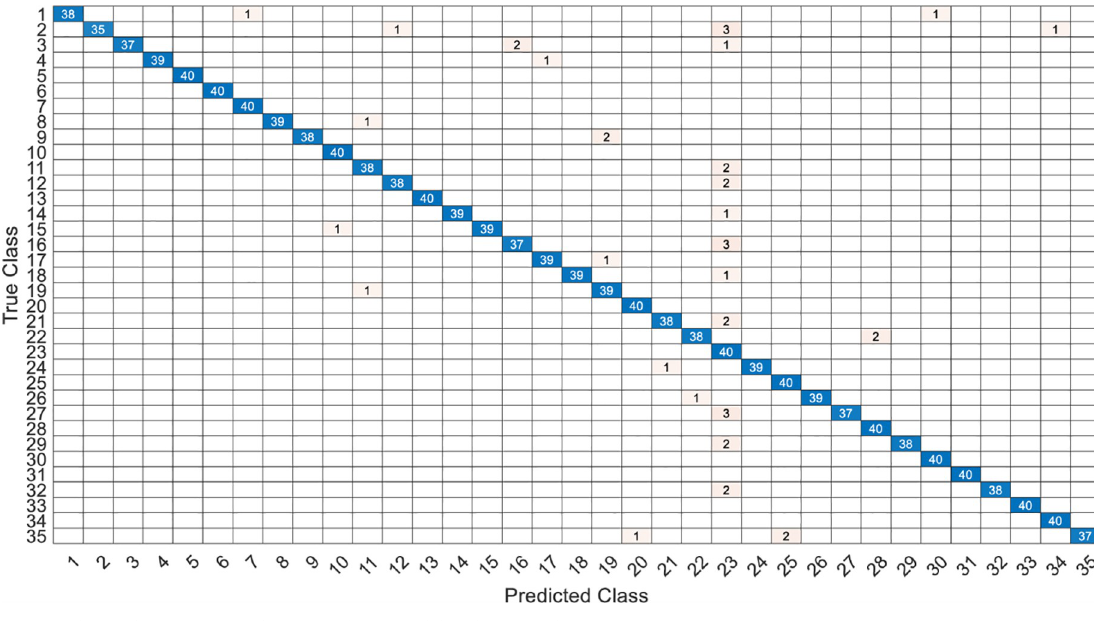
Fig 33. The confusion matrix of DNN-12-layer model with MFCC